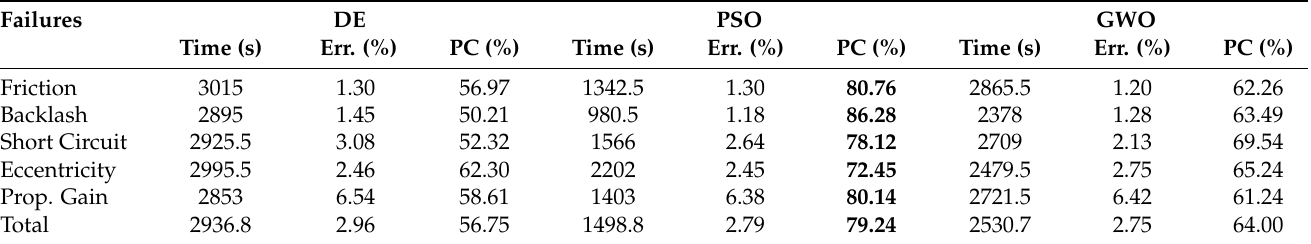
Table 3. Different optimization algorithms outcomes with single failures [10]. The values related to best performing algorithm (PSO) are highlighted in bold, along with the relative PCs.